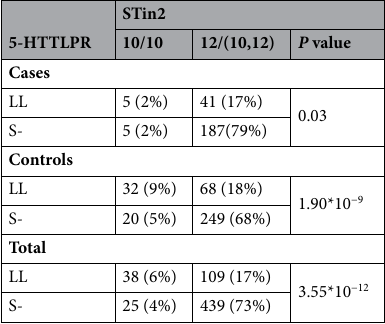
Table 6. 5-HTTLPR and STin2 risk alleles interaction.